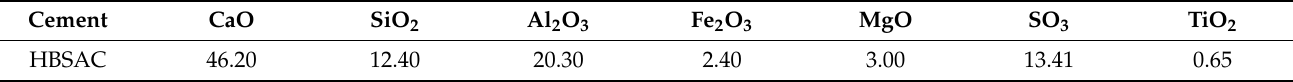
Table 1. The chemical component of HBSAC.